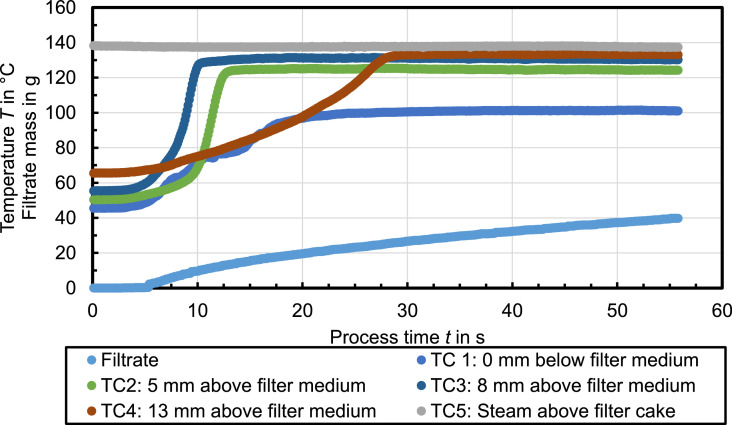
Celite®512 & Water (Δp = 2.4 bar, Tst = 138°C, hFC = 20 mm); RM = 48.5 %, rC = 4 × 1013 1/m²